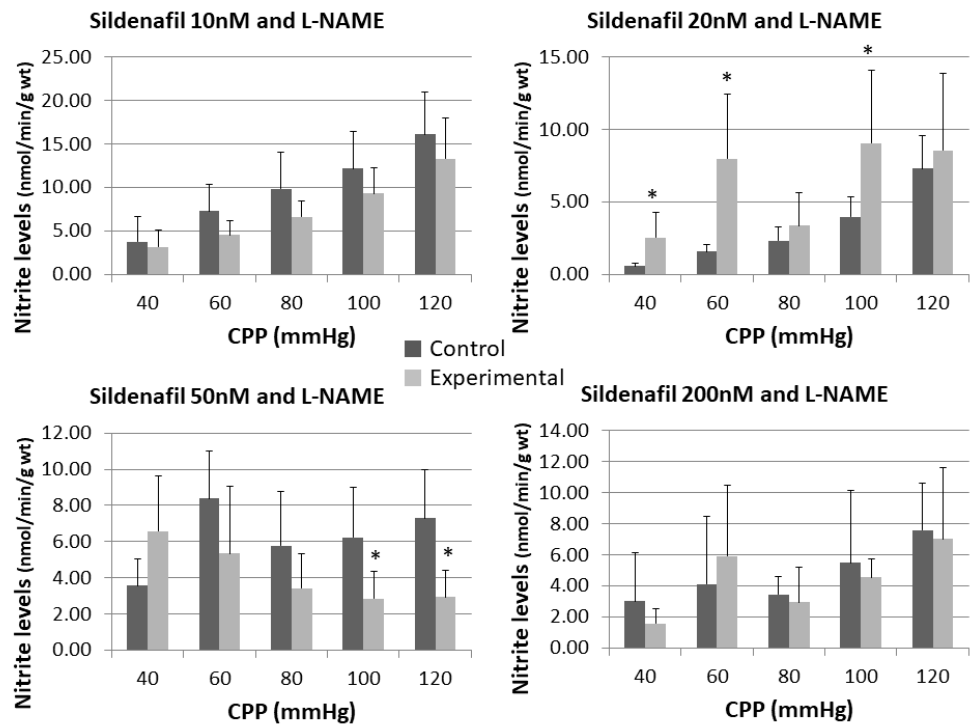
Figure 4. Influence of different sildenafil doses + L-NAME on the dynamics of released nitrite in the isolated rat heart. * p < 0.05, Mixed between-within subject ANOVA; Tukey’s